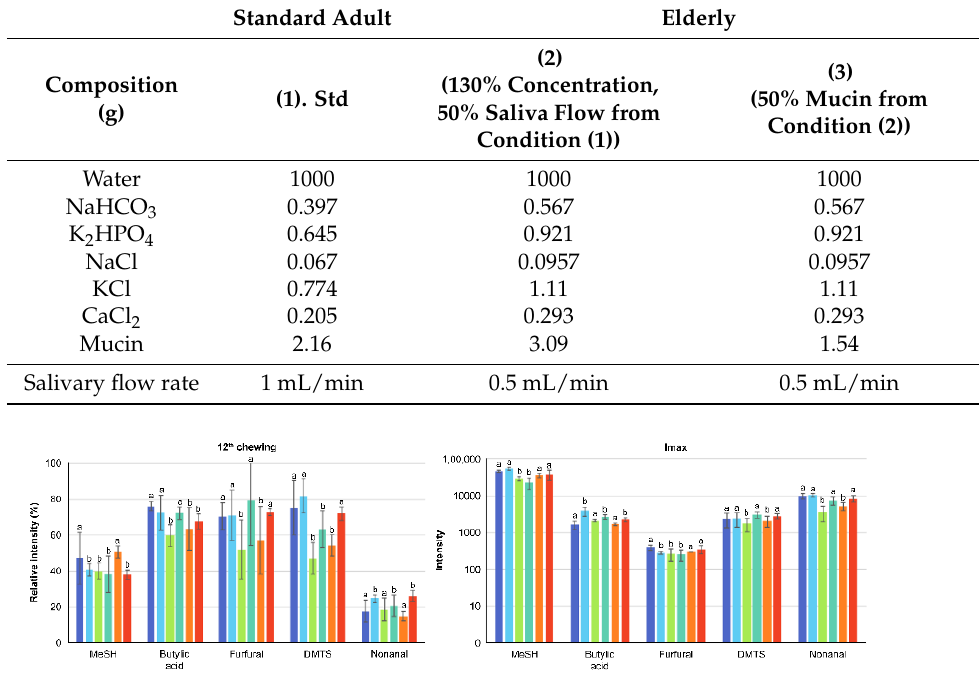
Table 2. Salivation conditions tested. Standard adult (1) and elderly artificial saliva compositions and flows (2 and 3).